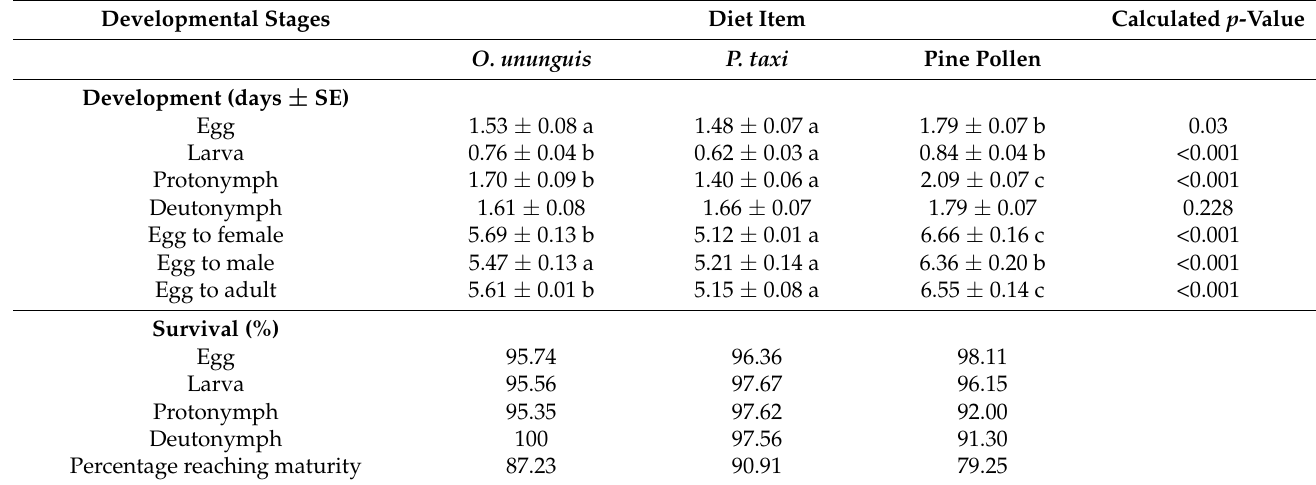
Table 1. Effect of different diets on the development and survival rate of A. andersoni. Values with different letters in a row differ significantly at p ≤ 0.05.